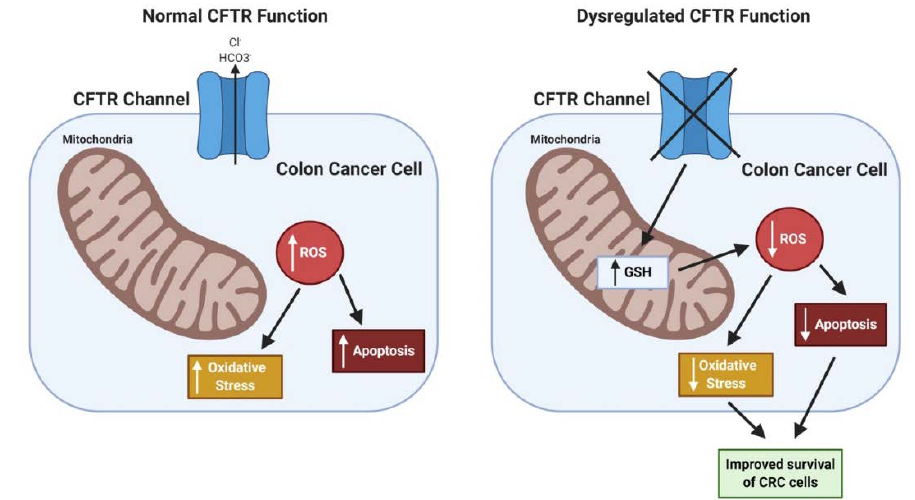
Figure 3. CFTR deficiency improves survival of CRC cells under oxidative stress. Cancer cells are subject to oxidative stress via increased production of reactive oxygen species (ROS) and are therefore susceptible to oxidative-stress-induced cell death. A potentially protective mechanism for CRC cells involves CFTR-deficiency leading to increased retention of the antioxidant glutathione (GSH) in mitochondria. Enhanced GSH could cause decreased ROS levels, decreased oxidative stress and decreased apoptosis. Through this mechanism CFTR-deficiency may promote survival of CRC cells. Figure created using BioRender.com.